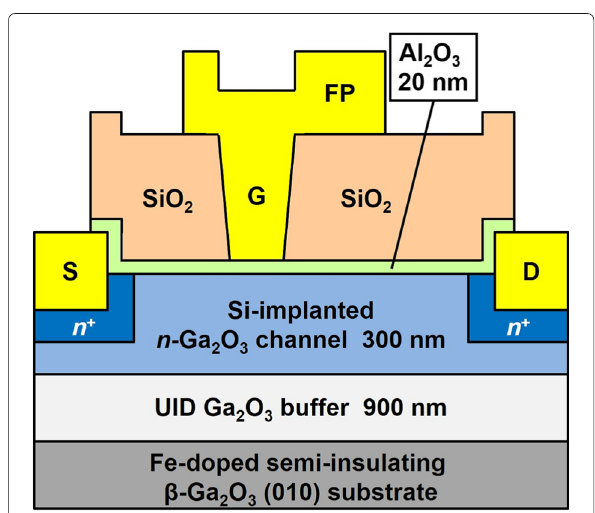
Fig. 11 Schematic cross section of field-plated Ga 2 O 3 MOSFET. Adapted with permission [88]. Copyright 2016, IEEE